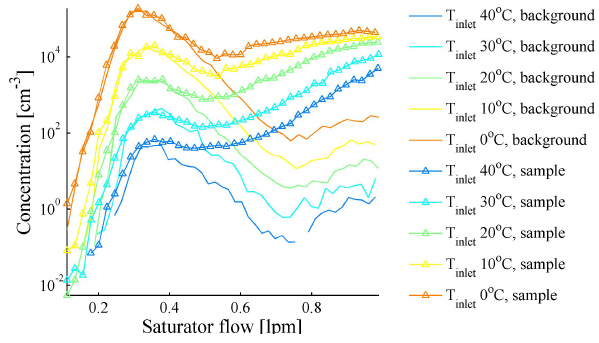
Figure 9. Concentration of homogeneously nucleated droplets (background) and detected concentration of positively charged THABr monomer (sample) at equal supersaturation. Concentration peak at saturator flow rate 0.3Lmin − 1 can be attributed to high supersaturation in the mixing region, while detection of THABr monomer at larger saturator flow rates than 0.3Lmin − 1 can be at- tributed to high supersaturation in the growth tube.